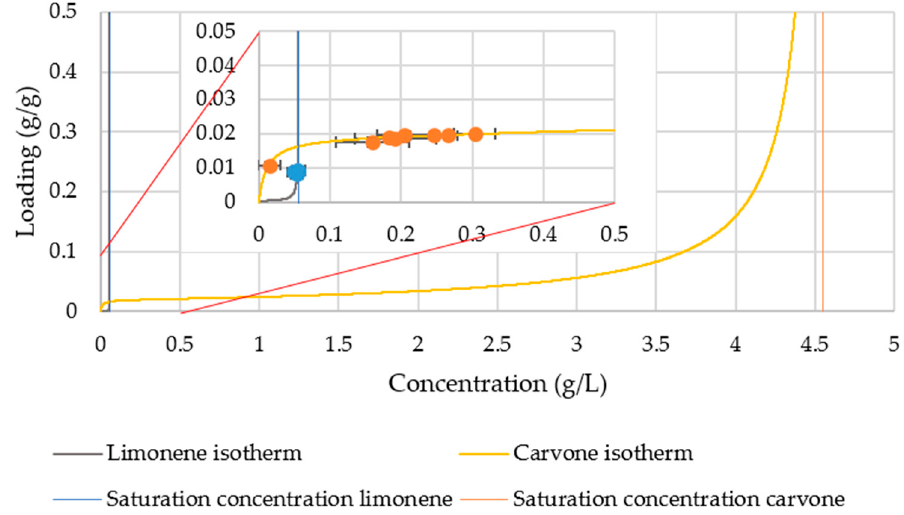
Figure 11. Brunauer isotherms of the caraway system.